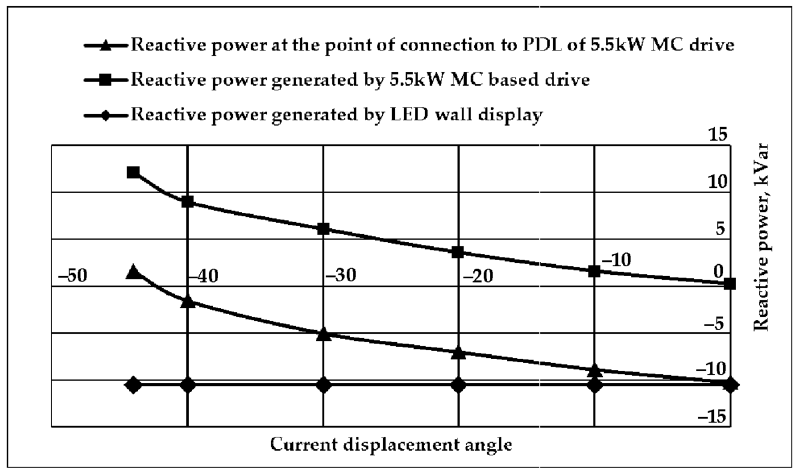
Figure 17. The reactive power of the LED display and the MC-based VFD as a function of the current displacement angle. displacement